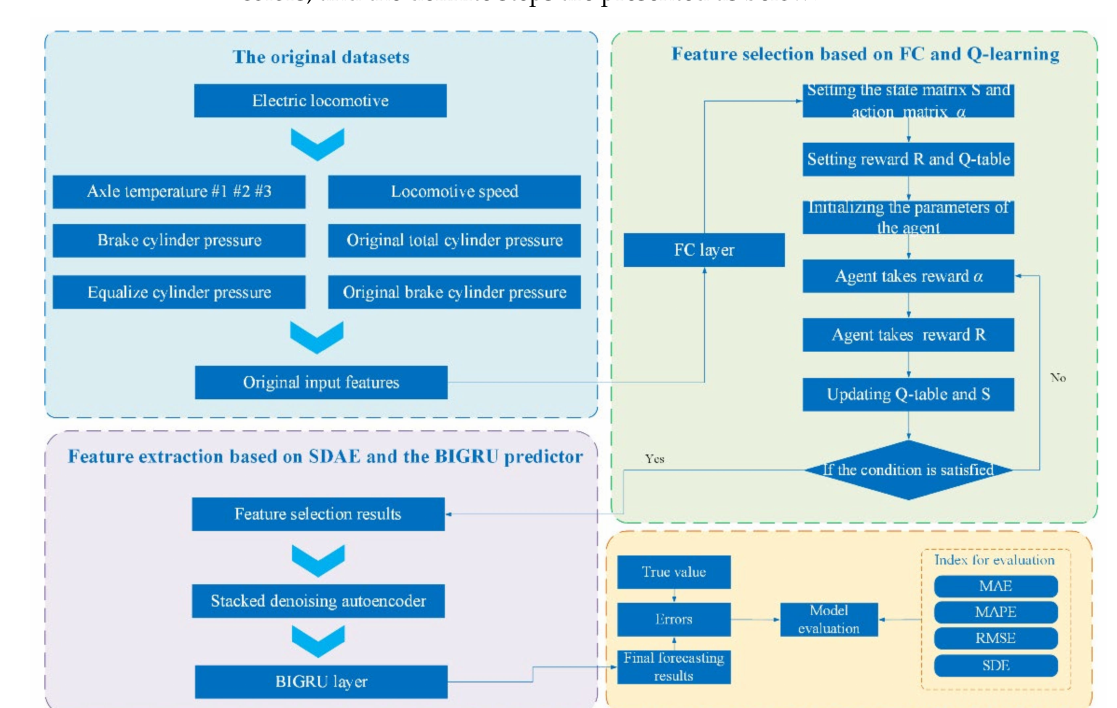
Figure 1. The flowchart of the proposed model.